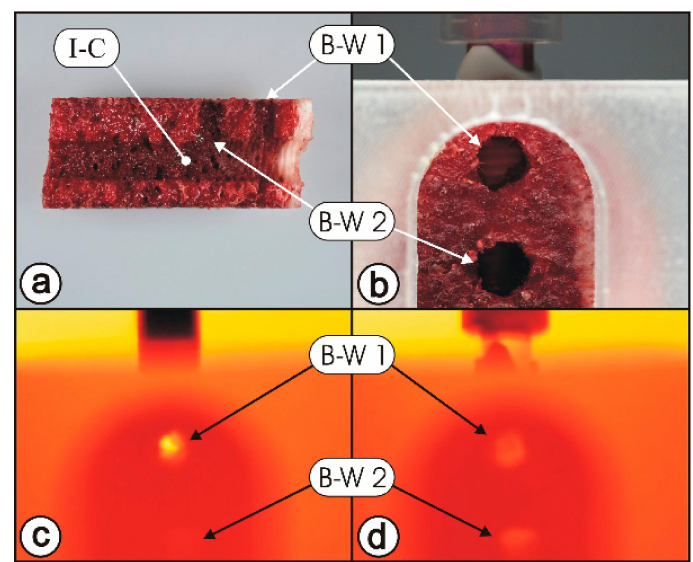
Figure 4. Dynamic temperature record at the bone–implant interface. ( a ) Transection of a rib segment; ( b ) overview of a rib segment; ( c ) infrared image at T3 in Figure 5; ( d ) infrared image at T7 in Figure 5.